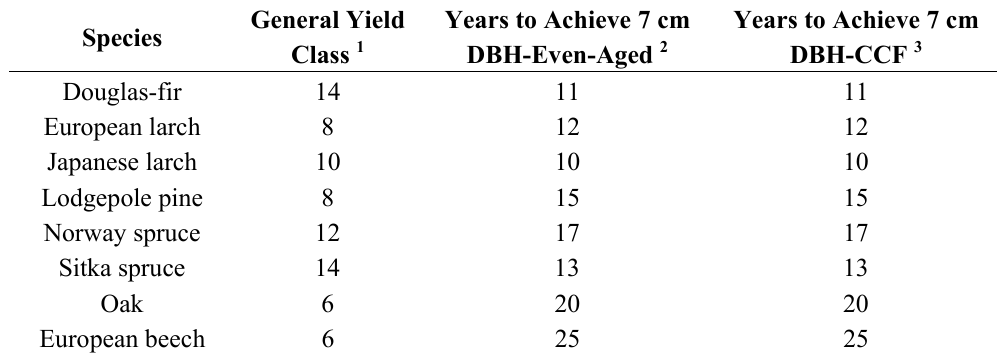
Table 5. Estimated time for species to achieve 7 cm diameter at breast height (DBH) under continuous cover management in